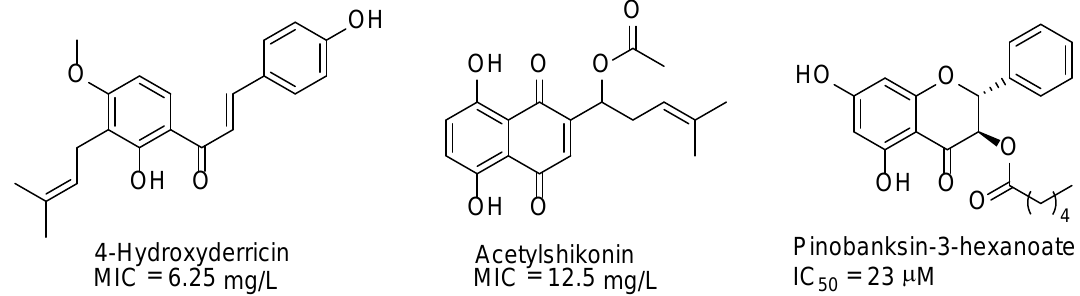
Figure 1. Structures of natural compounds with fungicidal activity against A. apis.